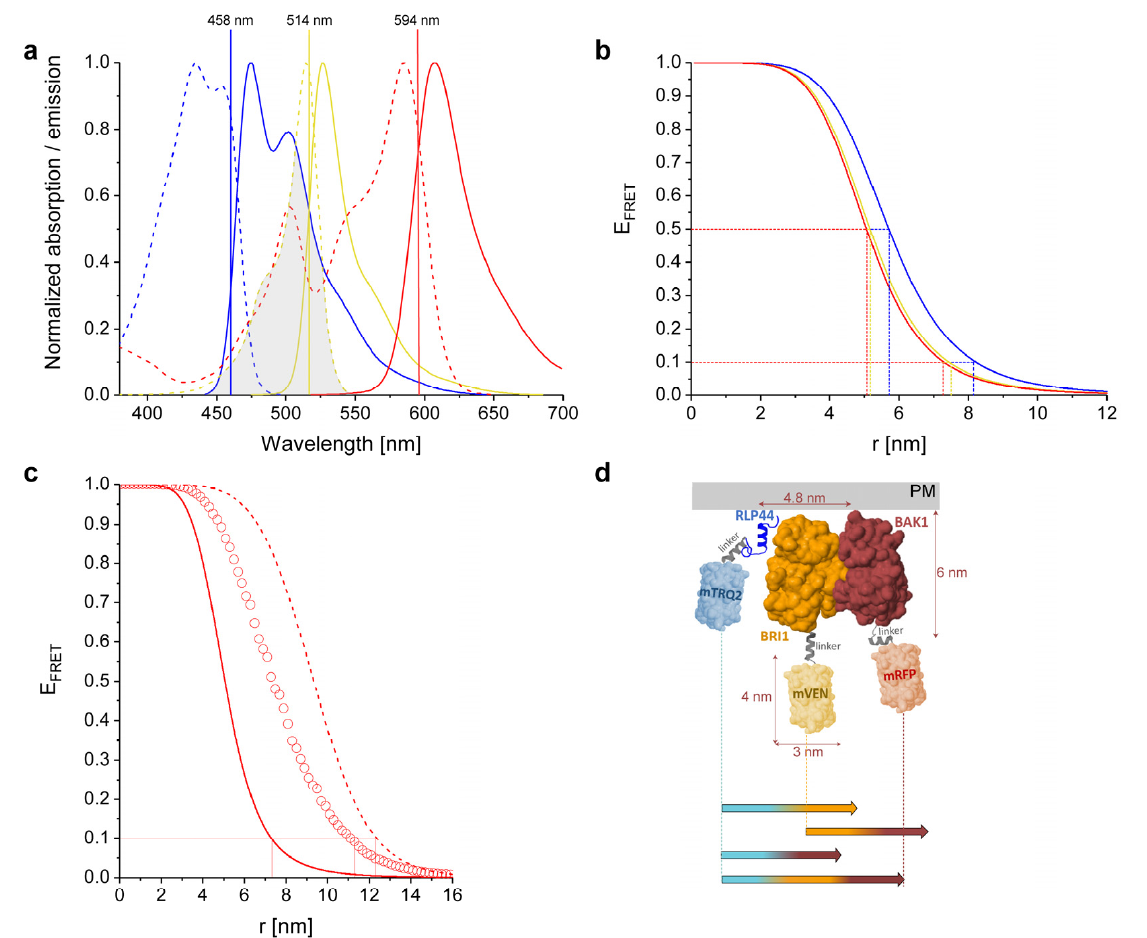
Figure 1. Spectroscopic and FRET properties of the used fluorophores and dimensions of the analyzed RLP44-mTRQ2, BAK1-mVEN and BRI1-mRFP fusion proteins. ( a ) Normalized absorption (dotted lines) and emission (solid lines) spectra of mTRQ2 (blue), mVEN (yellow) and mRFP (red). mTRQ2 is donor to both mVEN as acceptor 1 as well as mRFP as acceptor 2; mVEN is also donor to mRFP. The shaded area corresponds to the spectral overlap between donor emission and acceptor absorption, shown here exemplary for the mTRQ2/mVEN FRET pair. The laser lines for excitation of mTRQ2 (blue), mVEN (yellow) and mRFP (red) are marked as vertical lines at their respective wavelength positions. ( b ) FRET efficiencies (E FRET ) for the distances (r) between donor and acceptor fluorophores for mTRQ2-mVEN (blue), mVEN-mRFP (yellow) and mTRQ2-mRFP (red). The Förster distances R 0 at E FRET = 50% as well as the distances that correspond to E FRET = 10% (r 10% ) for each pair are marked with dashed lines in the respective color. ( c ) E FRET in dependence of distance r between mTRQ2 and mRFP without (solid line) and with intermediate mVEN located either equidistantly (dashed line) or variably (circles) between mTRQ2 and mRFP. For the latter, mVEN was placed at 1000 random positions for each mTRQ2/mRFP distance, averaging over the resulting E FRET values. The r 10% distances are marked with red lines. ( d ) Composite image of the cytoplasmic domains of RLP44 (blue), BRI1 (orange) and BAK1 (brown) fused to the 15amino acid-long Gateway ® -linker to either mTRQ2 (light blue), mVEN (light yellow) or mRFP (light red). The structures of the cytoplasmic domains of BAK1, BRI1 and the fluorophores are shown as solvent-accessible surface models, while the model structures of the cytoplasmic domain of RLP44 and the three Gateway ® -linkers (grey) were predicted with PEP-FOLD3 and depicted as cartoons. The orientation of the kinase domains of BRI1 and BAK1 to each other was designed according to a molecular docking analysis in orientation to the PM [20]. The colored arrows below the structures show the r 10% distances for all FRET pairs and the three-chromophore FRET cascade with mVEN inserted at random positions, calculated for a donor to acceptor complex ratio of 1:1. The precise values for b, c and d are listed in Table